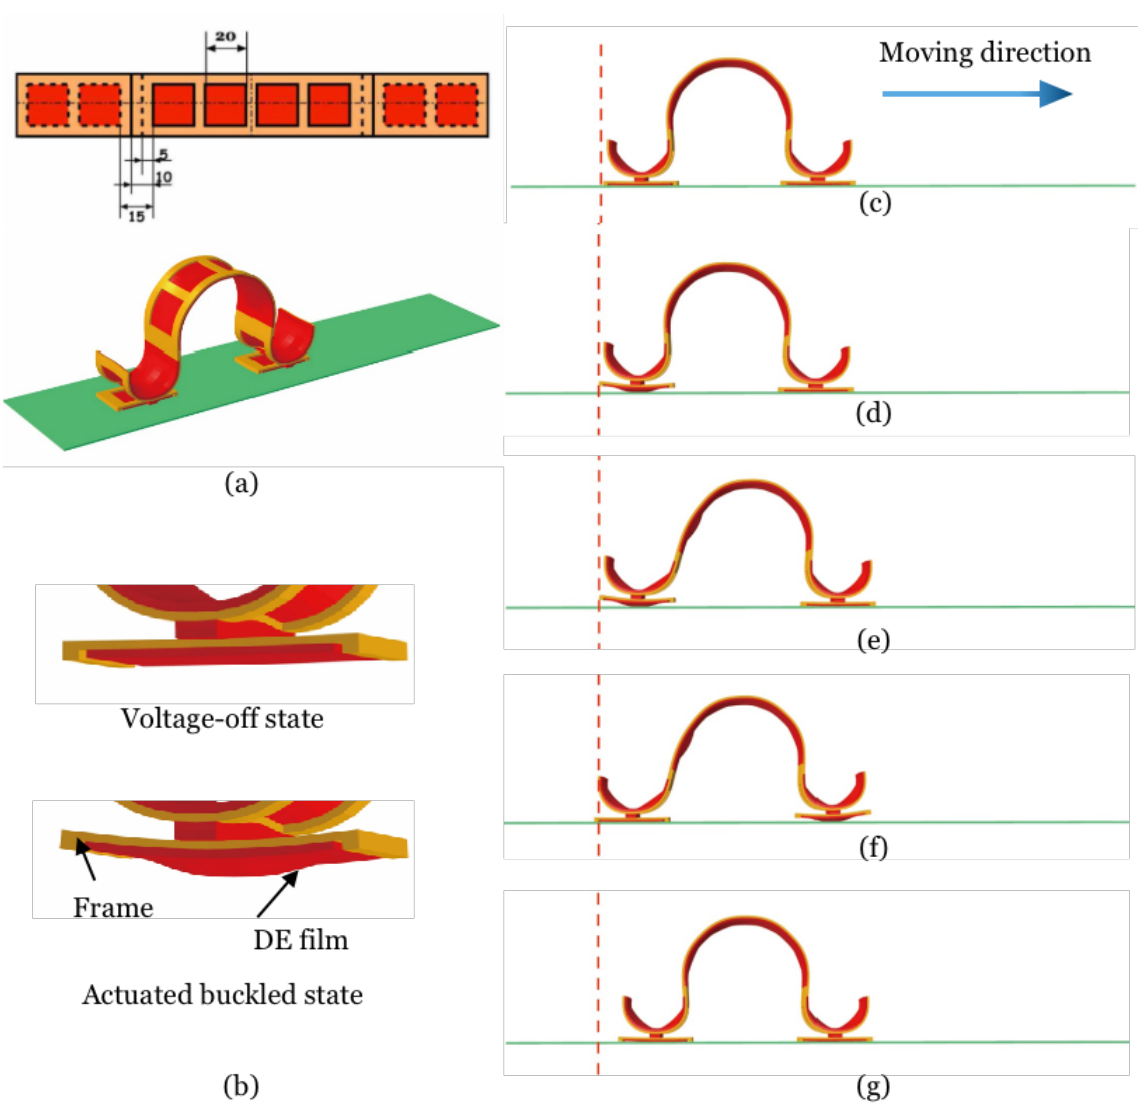
Figure 2. Design and modeling of a DEMES walker with switchable asymmetric feet realized by harnessing buckling instability. ( a ) Planar view and as-fabricated state of the DEMES walker. The central body consists of six DEMES units with a red color DE membrane and a yellow color frame. ( b ) Zoomed in picture of the voltage-off state (left) and actuated buckled state (right) of a foot for the walker. In the voltage-off state, the smooth frame is in contact with the ground, and a friction-free state is assumed, while in the buckled state the bulged DE membrane is in contact with the ground and a high friction coefficient is attained, realizing a foot design with switchable friction coefficients. ( c – g ) A series of actuations taken by the DEMES walker in order to realize locomotion.